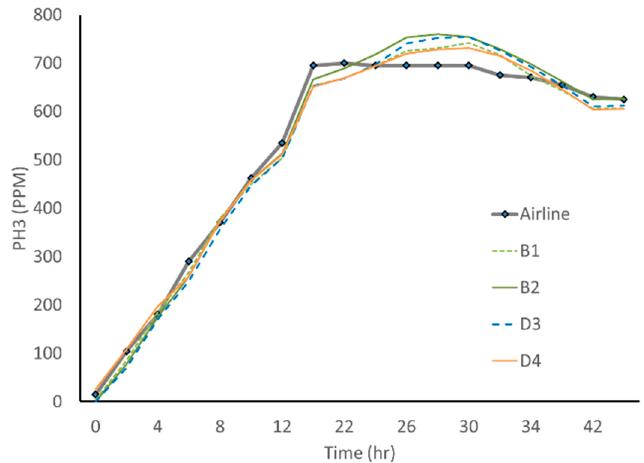
Figure 4. The repeatability and relative accuracy chart for four phosphine sensors compared to the hand-held meter. Sensors B1, B2, D3, and D4 were placed into a barrel together along with an airline. B1 and B2 were wireless sensors used later in bin B, while D3 and D4 were wireless sensors used in bin D.